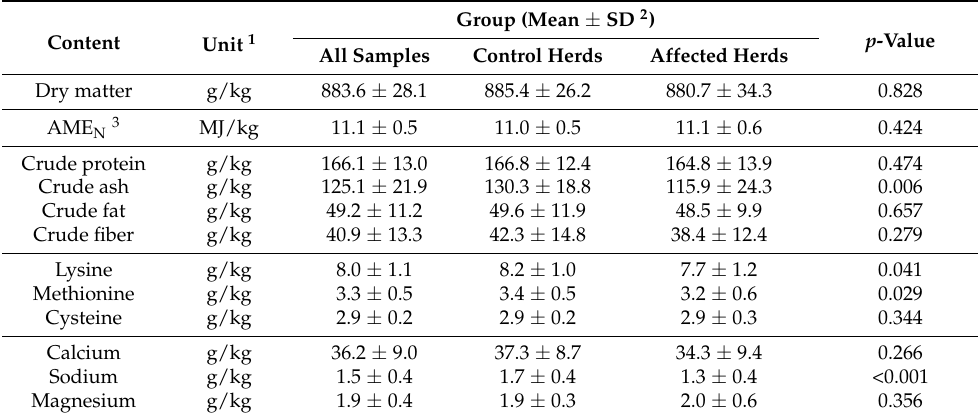
Table 3. Energy and nutrient contents in compound feed samples from laying hen herds with ( n = 37) and without plumage damage ( n =